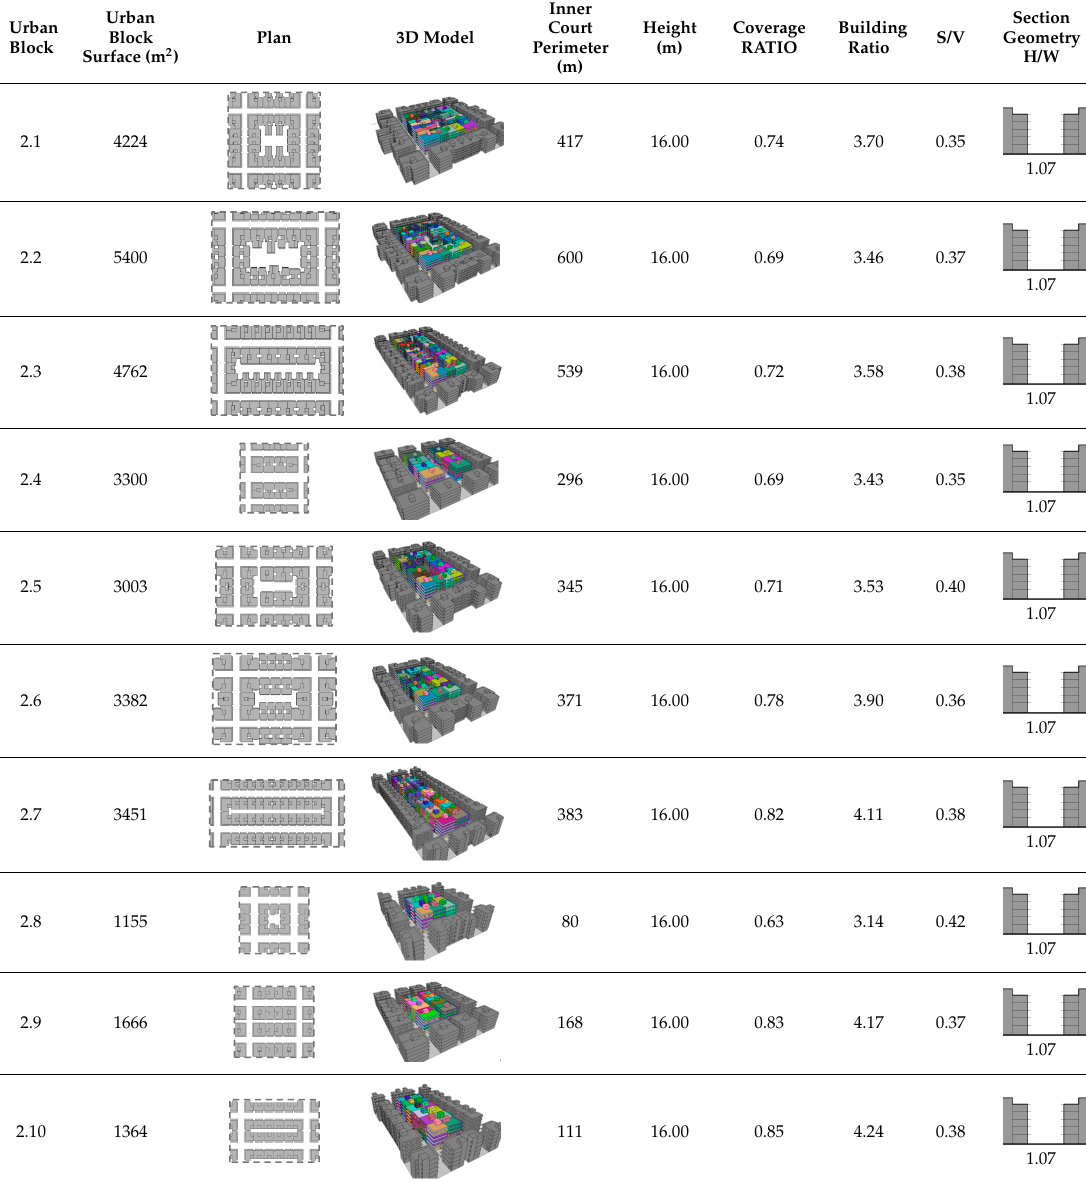
Table 2. Form and geometry parameters of typical urban blocks included in group 2.